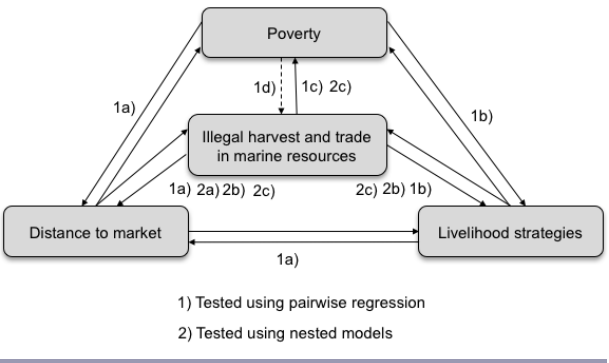
Fig. 2 . Schematic representation of the hypothetical models for illegal harvest and trade in marine resources. The solid lines explore the relationship between illegal activities and the other variables. The dashed line explores whether poverty drives illegal